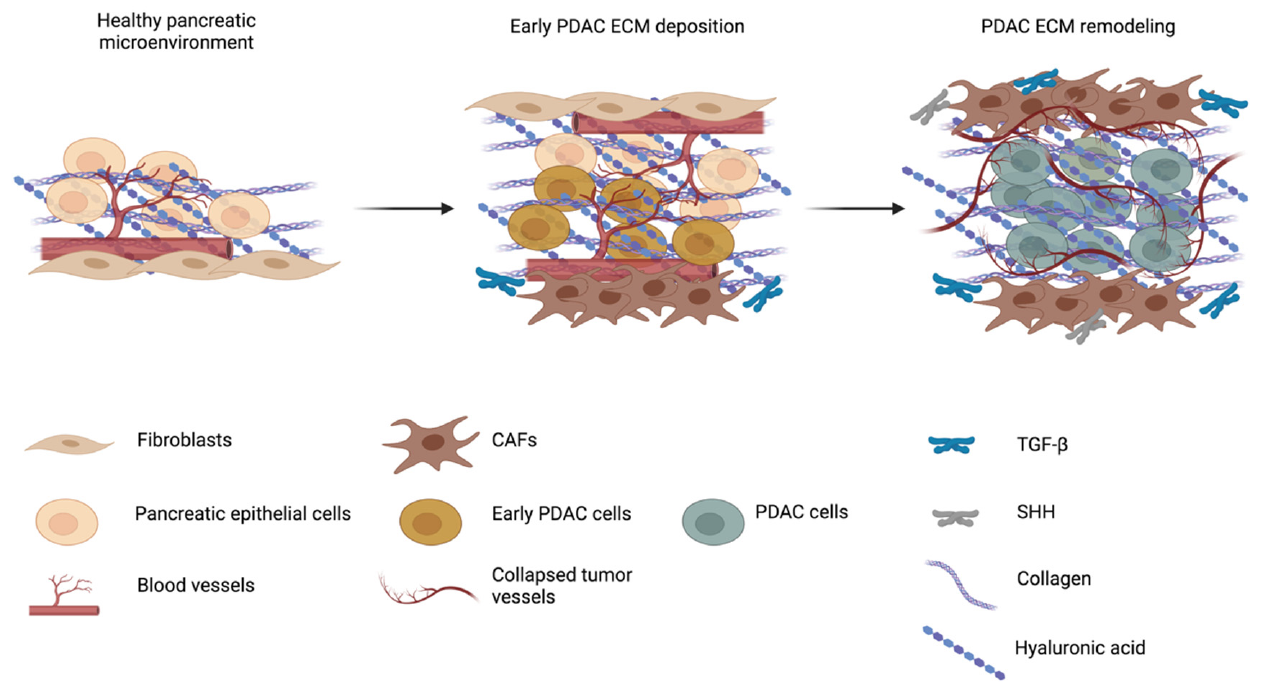
Figure 1. The extracellular matrix (ECM) modifications in pancreatic ductal adenocarcinoma (PDAC). In physiological conditions, pancreatic epithelial cells are surrounded by the ECM with its molecular components; cells providing structural and nutritive support, such as fibroblasts; and the vasculature network. During tumor transformation, the enhanced ECM deposition by cancer-associated fibroblasts (CAFs) is aided by molecular messengers such as the tumor growth factor ß (TGF-ß) or sonic hedgehog (SHH), and forms a dense and stiff matrix around early PDAC cells. This complex meshwork, together with the formation of new collapsed and leaky blood vessels, creates a tumor microenvironment, which favors PDAC growth and invasiveness, activating intracellular pathways that induce pro-tumorigenic programs.